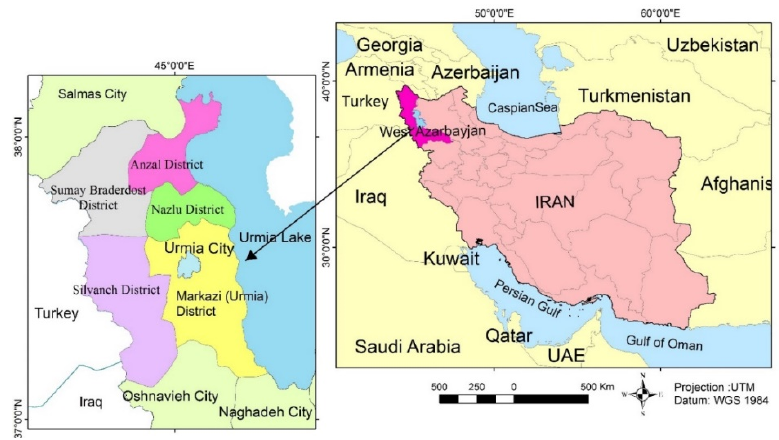
Figure 3. Iran, West Azarbayjan Province and the city of Urmia.